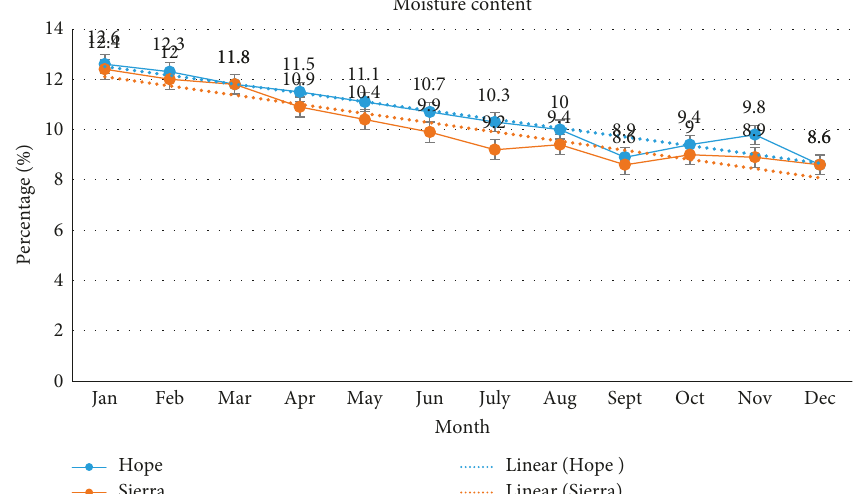
Figure 6: Comparison of moisture content trends for Hope and Sierra malting barley varieties over the 12-month storage period.